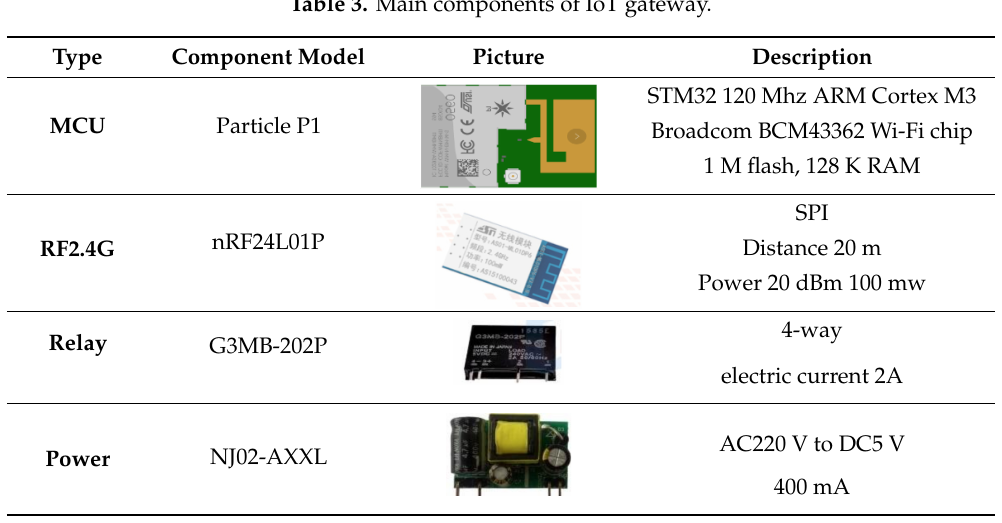
Figure 4. Internet of Things (IoT) gateway block diagram and working board. Table 3. Main components of IoT